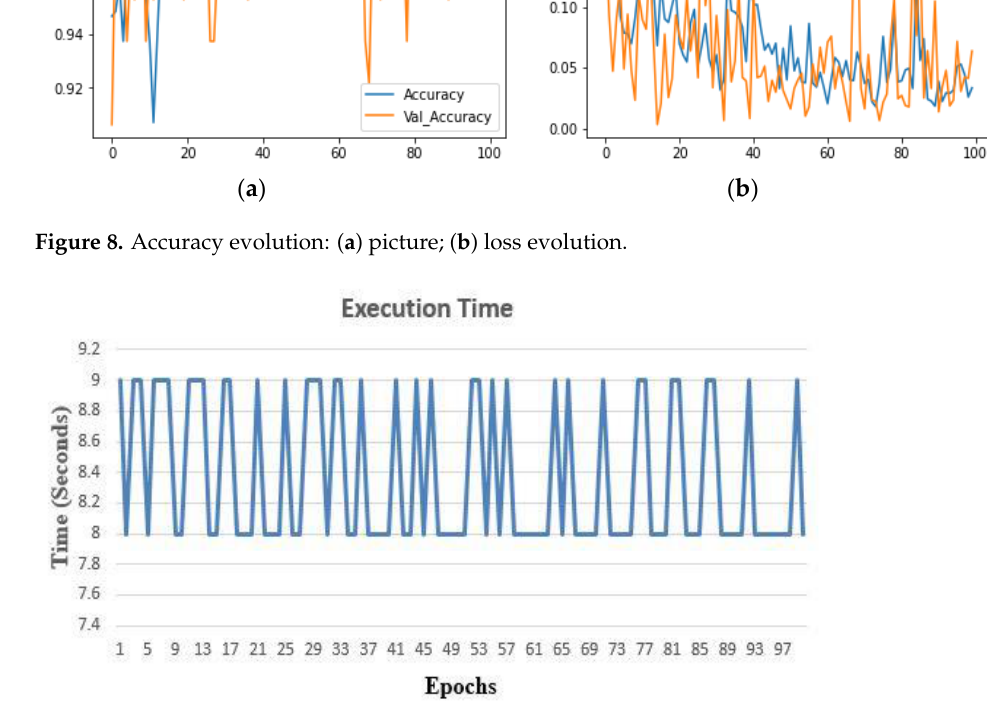
Figure 9. Graph with the execution time of each epoch.